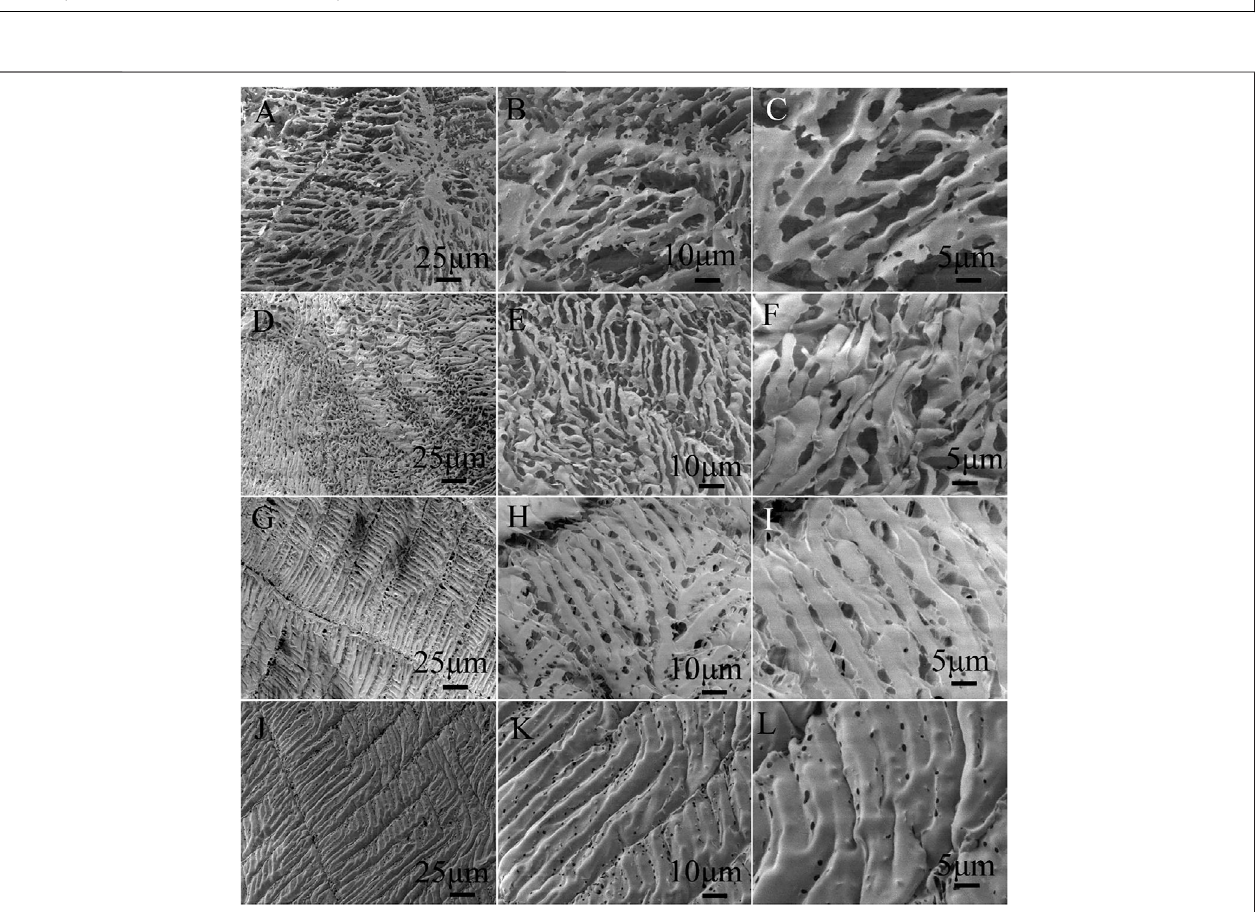
FIGURE1| 1 HNMRspectra (A) andFT-IRspectra (B) ofHPAM(n AM /n AA (cid:2) 9/1),z-HPAM(n AM /n AA /n MDSA (cid:2) 9/1/1),p-HPAM(n AM /n AA /n PEGMA (cid:2) 9/1/0.14),andzp- HPAM (n